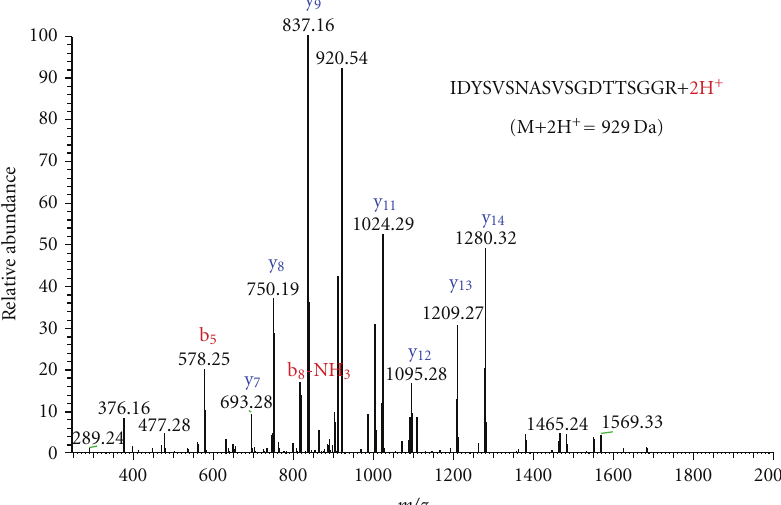
Figure 5: Fragmentation pattern of doubly charged peptide IDYSVANASVSGDTTSGGR (residues 51 to 69) from the protein arylesterase of B. vietnamiensis